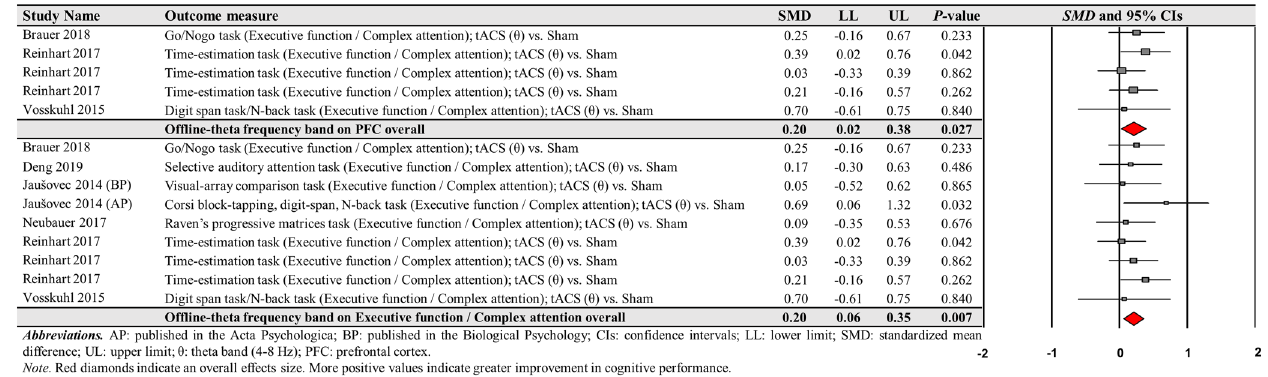
Fig. 10 Cognitive performance comparisons after of fl ine-tACS with theta frequency band across targeted brain regions and cognitive domains. Meta-analytic fi ndings show potential effects of of fl ine-tACS protocols with theta frequency band on PFC and executive function / complex attention.